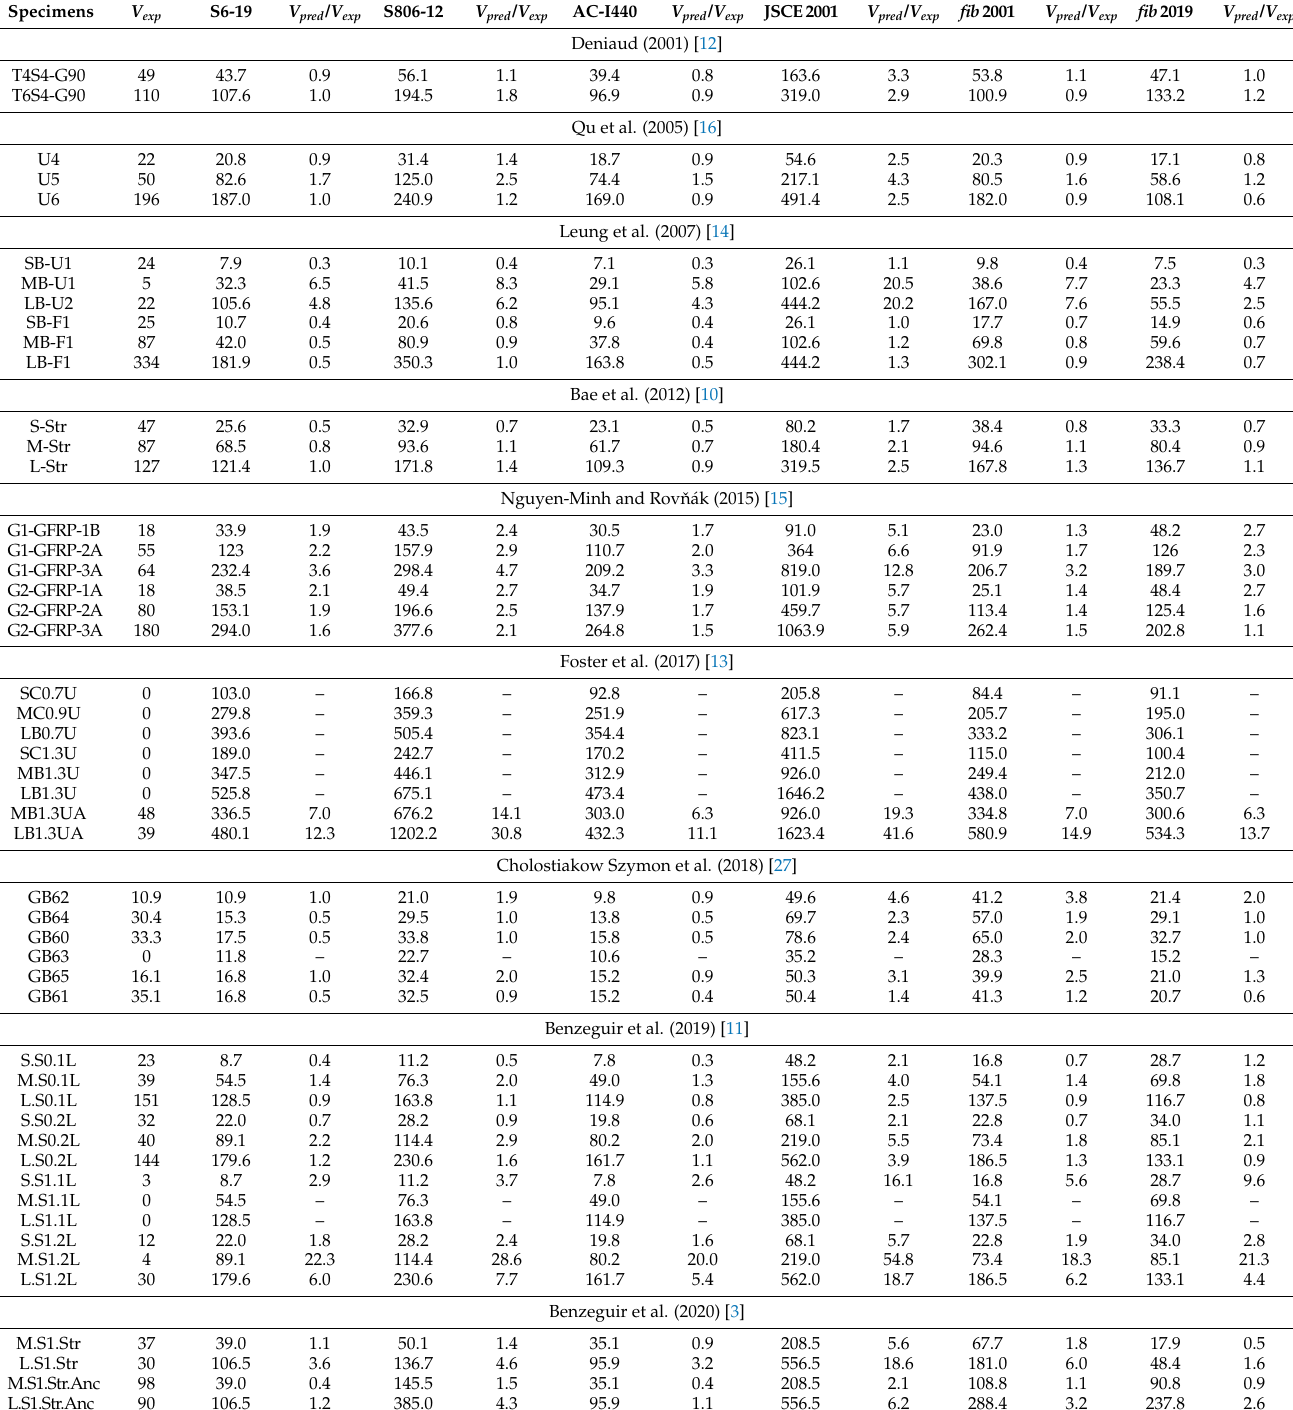
Table 7. Comparison of experimental results versus prediction models of codes and